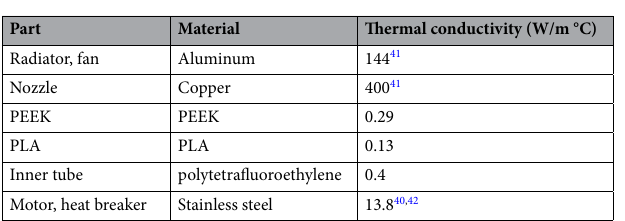
Table 1. Thermal property of different part.